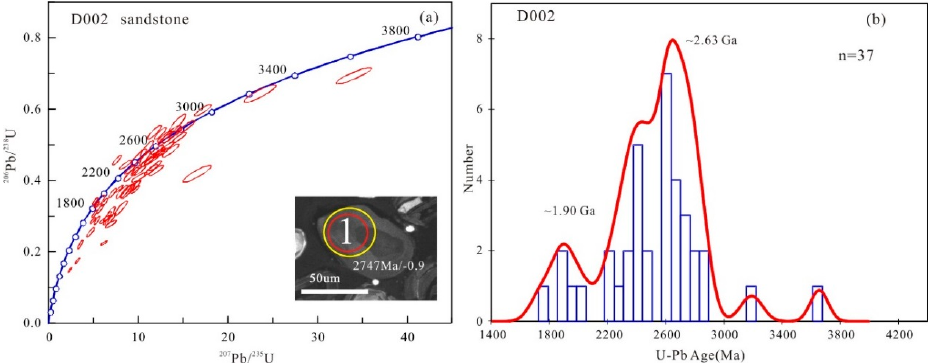
Figure 7. CL images and concordia plots ( a ) and statistical distribution ( b ) of zircon U–Pb dating for sandstone (D002) of DCG.